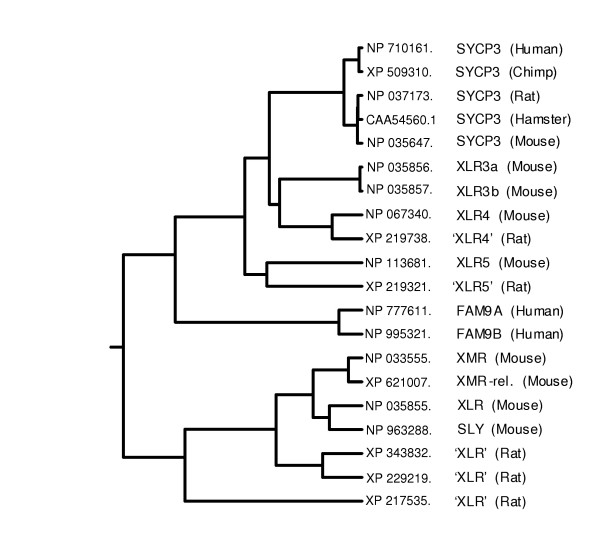
Dendrogram showing the relationship between the SLY protein and other identified or predicted mammalian Cor1 domain proteins. The autosomally encoded SYCP3 is the presumed ancestral gene because it has been identified in a wide range of vertebrate species. The remaining proteins other than SLY are X encoded. For the rat, the putative X-encoded proteins have not yet been named and the labels given are simply a reflection of their position within the dendrogram. The massive expansion in copy number is only seen in the branch containing XMR, XMR-rel., XLR and SLY. This amplification therefore occurred subsequent to the divergence of mouse and rat lineages, concurrent with the appearance of Sly on the Y chromosome.